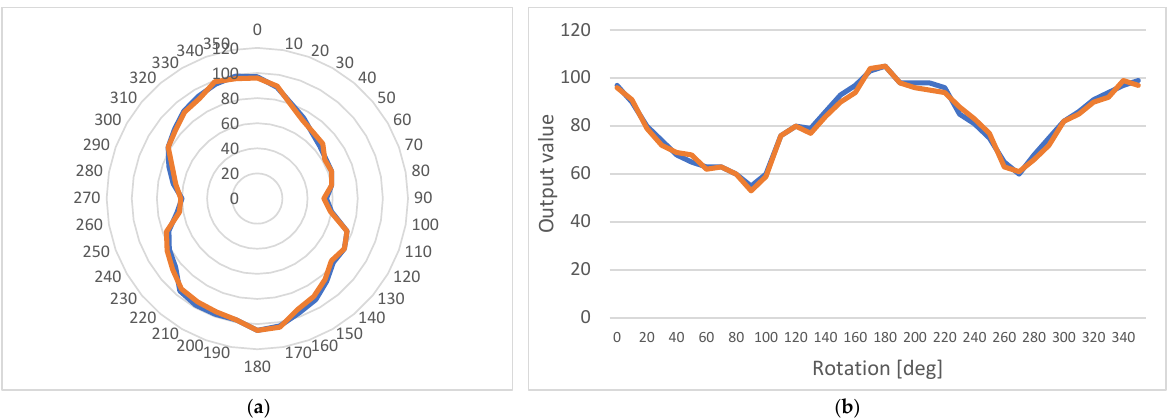
Figure 20. Anisotropic behavior of the sample before the flaw; measurement on point (orange line) and with a 5 mm offset (blue line): ( a ) A polar diagram; ( b ) A linear diagram.